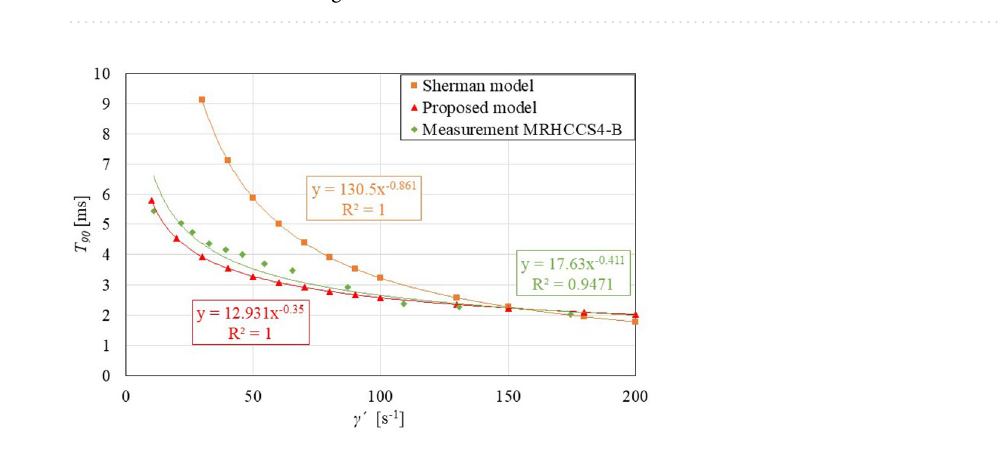
Figure 7. Dependency non-dimensional response time T ∗ on Mason number M n ; Data from other publications have been estimated according to available information.